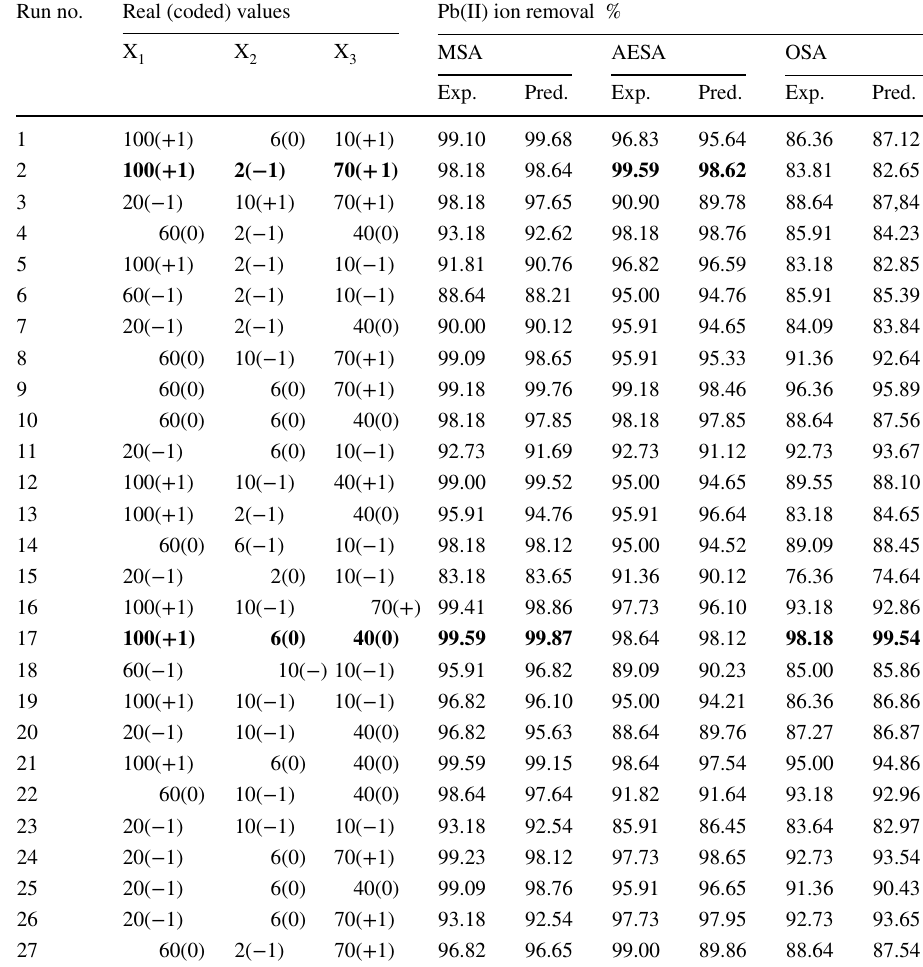
Table 2 Design matrix and BBD with experimental and predicted results for the removal of Pb(II) ions with MSA, AESA and OSA from an aqueous solution